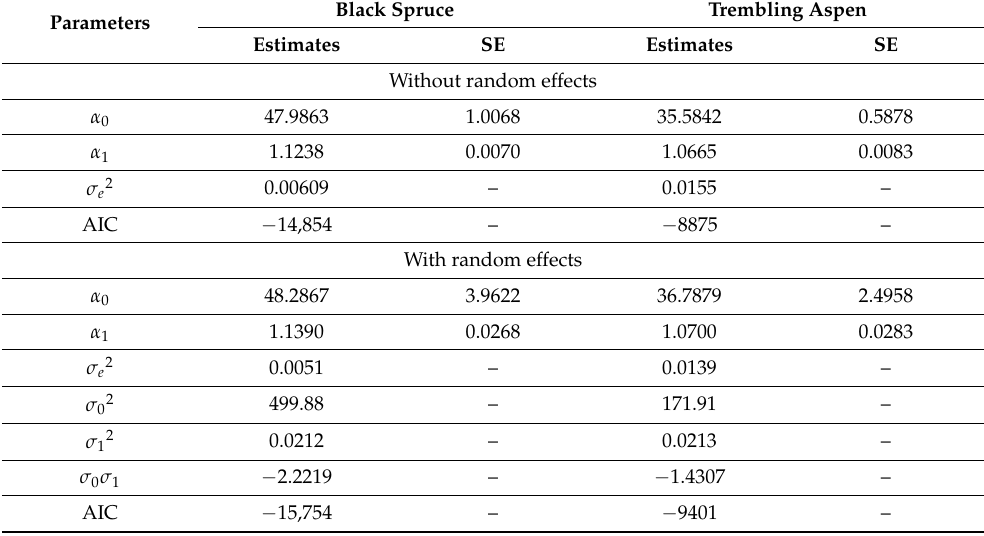
Table 2. Parameter estimates, standard errors (SE), fit statistics (MSE ( σ e 2 ), variance of b 0 ( σ 02 ), variance of b 1 ( σ 12 ), covariance of b 0 and b 1 ( σ 0 σ 1 ), and Akaike’s information criterion (AIC) for Equation (2) for black spruce and trembling aspen trees from Ontario,